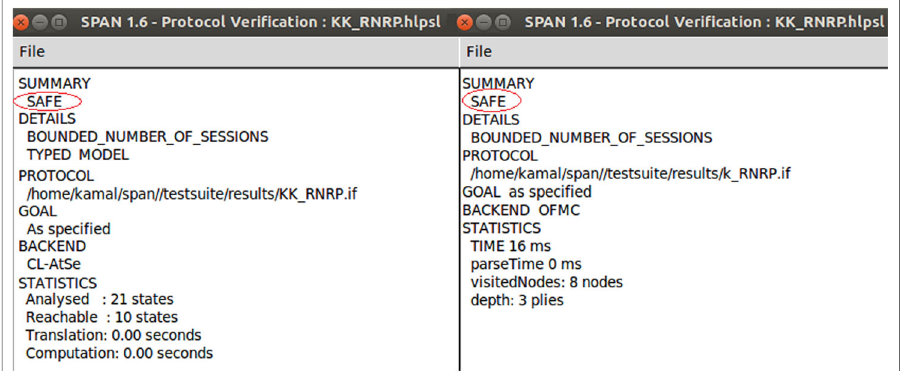
movements in the heterogeneous network environment are considered. Algorithm 1 ( A1 ) represents the standard authentication protocols EAP-AKA (cid:2) , INEA, and EPS-AKA [2]. Those protocols are invoked whenever the UE connects to a new network domain. Algo- rithm 2 ( A2 ) represents the use of fast re-authentication protocols [15], which are invoked whenever the user connects to a previously visited network domain. In addition, algo- rithm 3 ( A3 ) represents Coordinated Robust Authentication and re-authentication pro- tocols (CRA) [24]. Whereas the proposed authentication and re-authentication protocols are invoked in algorithm 4 ( A4 ) of the UE movements (handovers) model.